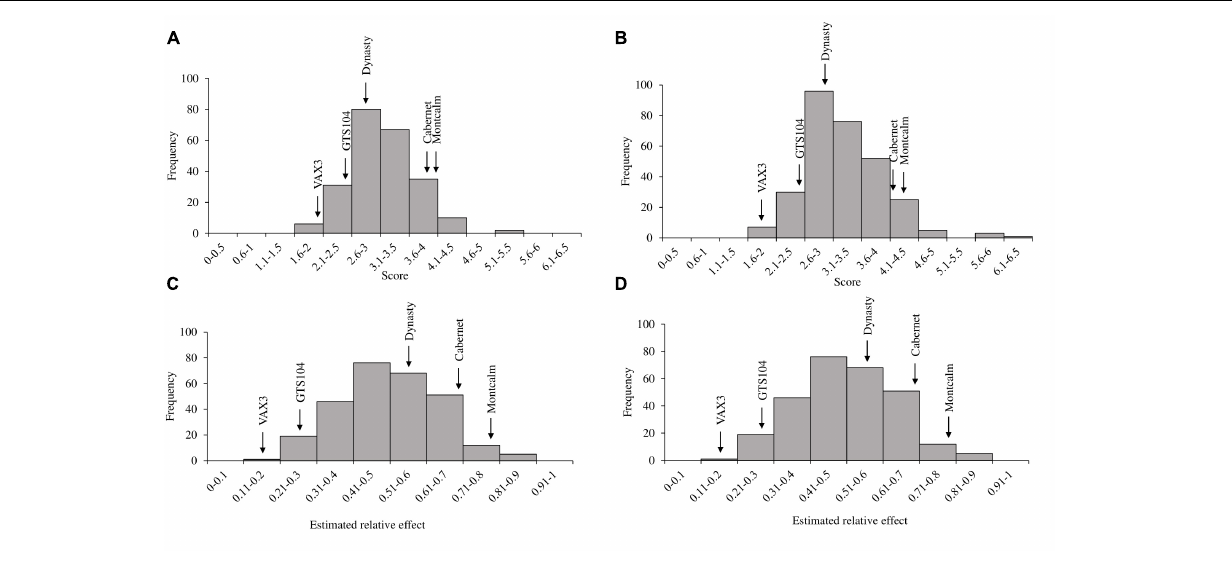
FIGURE 2 | Histograms of phenotypic evaluations of two Phaseolus vulgaris diversity panels. Distribution of (A) average disease score and (C) the estimated relative effects of root rot caused by R. solani AG 2-2 in the Andean Diversity Panel (ADP). Distribution of (B) average disease score and (D) the estimated relative effects of R. solani in the Middle American Diversity Panel (MDP). Arrows indicate the average disease score and relative effects of the five control lines used in the study.